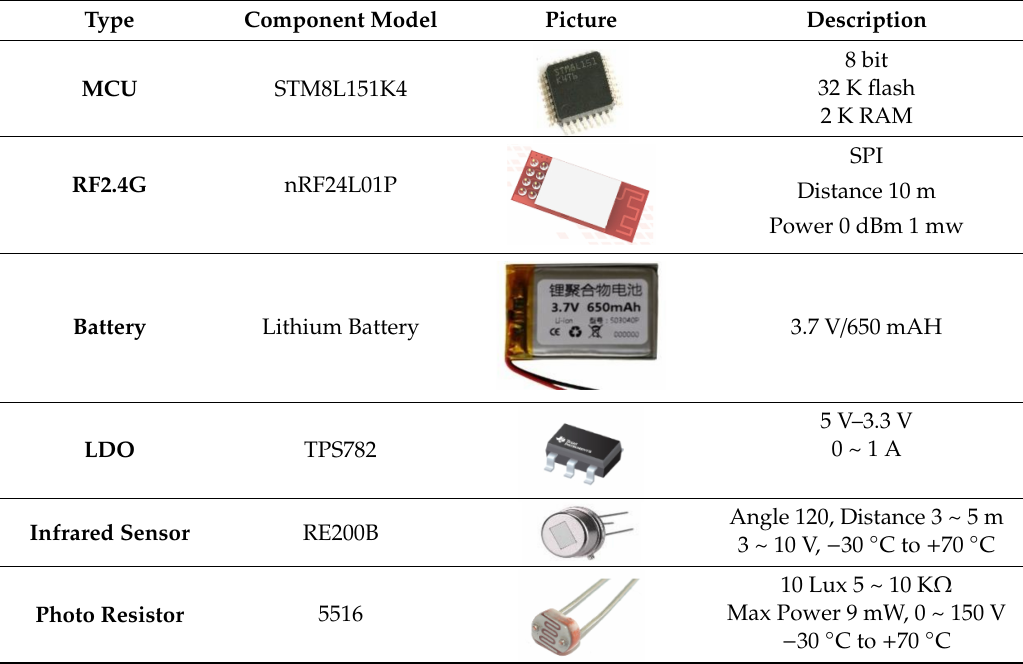
Table 6. Main components of sensor